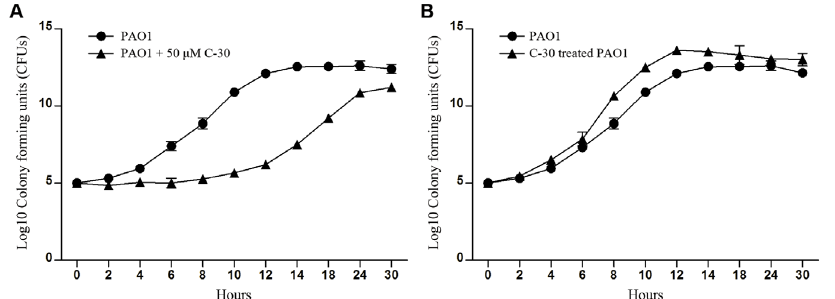
Figure 5. Furanone C-30-treated WT PAO1 showed enhanced cell proliferation compared with untreated group. (A) The growth of WT PAO1 was inhibited by furanone C before 12 hours culture. WT PAO1 was cultured with or without 50 m M furanone C-30 in LB broth medium and the CFUs were enumerated at designed time phases. (B) Furanone C-30-treated PAO1 cells harvested after 12 hour culture were immediately diluted to the same cell density (1.0 6 10 5 CFU/ml) with untreated PAO1 for further cultivation. Data are means 6 SEM, and representative of three experiments. Some error bars are too small to be seen.